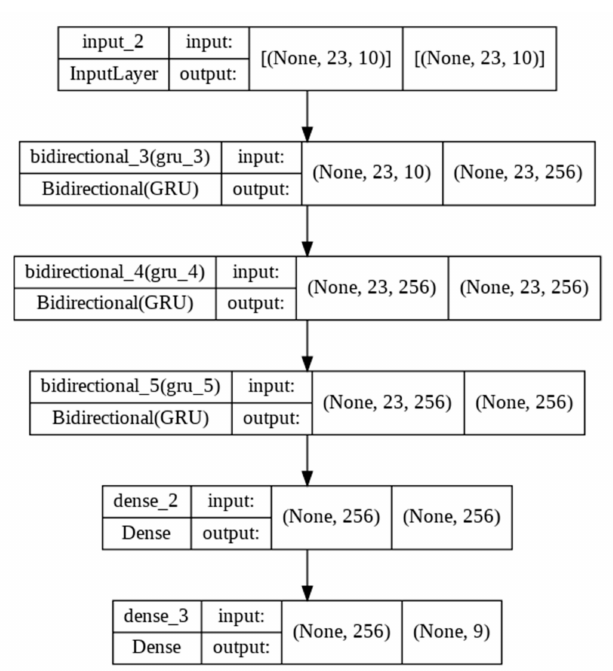
Figure A1. Bidirectional gated recurrent unit.